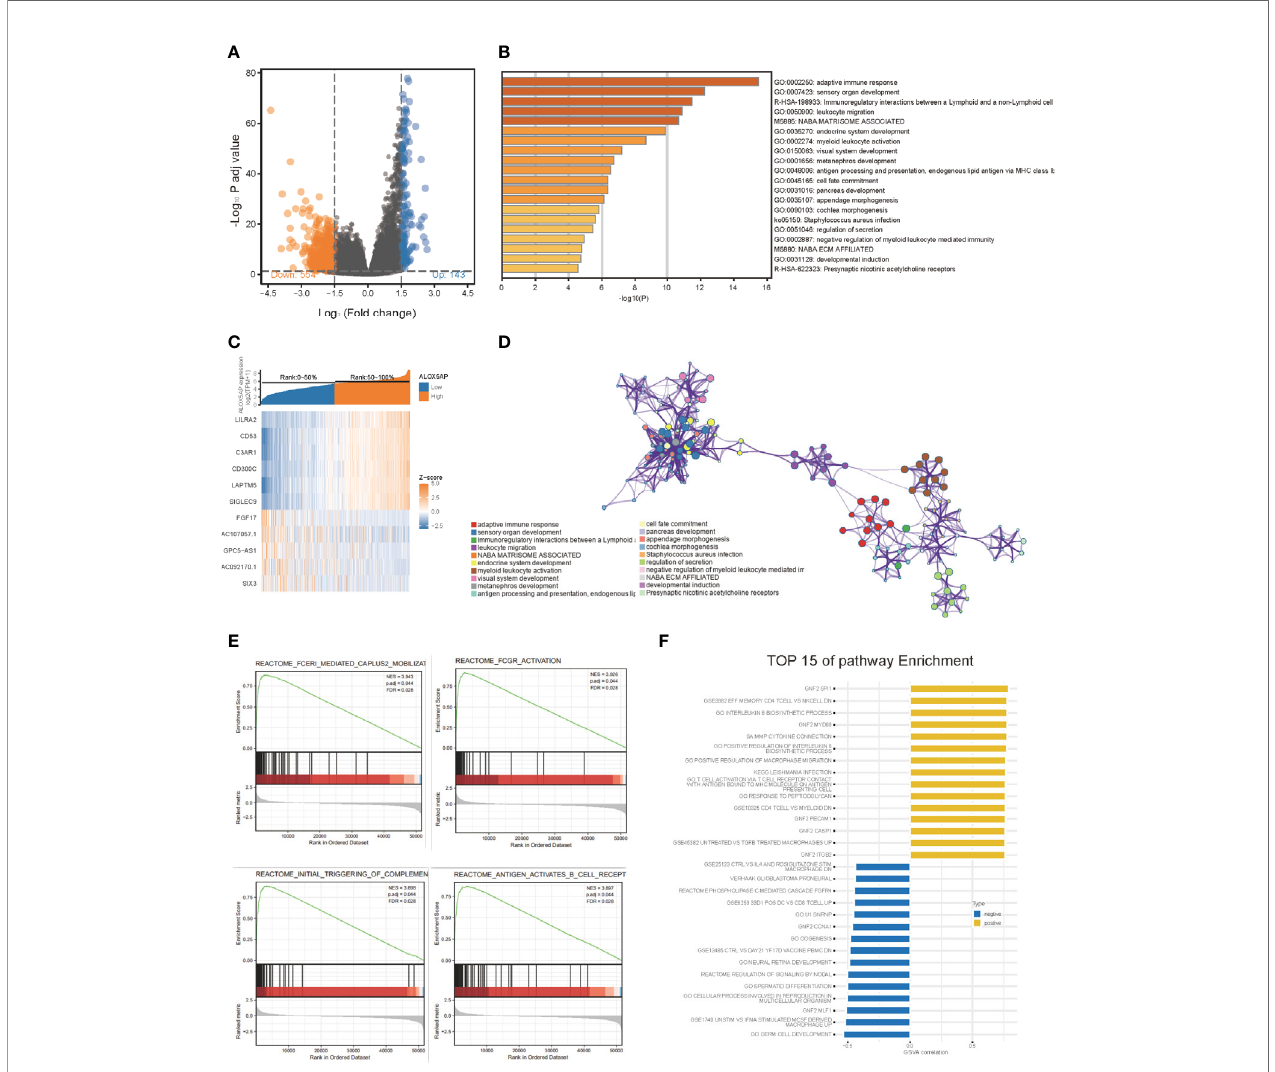
FIGURE 5 | The gene enrichment analysis of ALOX5AP in SOC. (A) Volcano plot of the differentially expressed genes (DEGs) between ALOX5AP high and low groups in the TCGA-OV dataset. (B) Representative heatmap of top regulated DEGs after integrated analysis. The X-axis represents the samples, while the Y-axis denotes the differentially expressed genes. (C) The Bar graph demonstrating the top 20 clusters of enriched biological processes. (D) Visualization of the network of enriched terms colored by cluster using Metascape tool. (E) Enrichment plots from the gene set enrichment analysis (GSEA) in ALOX5AP high expressed samples. (F) Top 15 enriched signaling pathways by Gene set variation analysis (GSVA) comparison of DEGs between ALOX5AP high and low expression